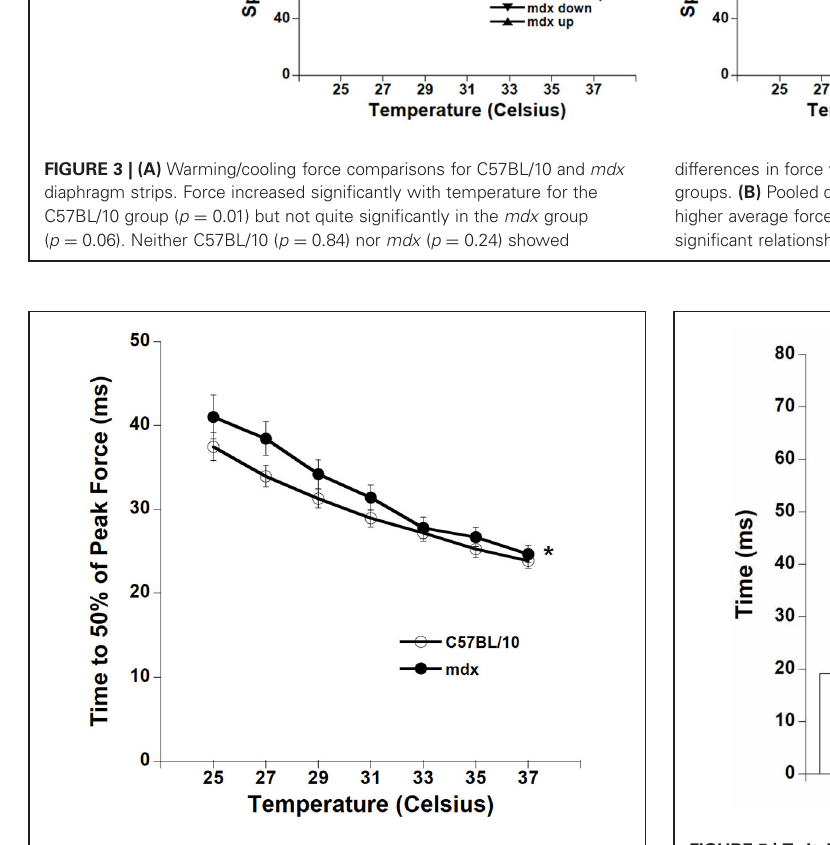
FIGURE 5 | Twitch-kinetic properties at 37 ◦ C. Time to peak tension (TTP) was slightly less in C57BL/10 strips vs. mdx strips, while time from peak tension to 90% relaxation (RT90) showed a similar trend. As a result, overall duration of contraction (TT90, taken from stimulation to 90% relaxation), was significantly longer in mdx vs. C57BL/10 muscle strips ∗ ( p < 0 . 05, 69 . 6 ± 10 . 1 vs. 54 . 3 ± 2 .